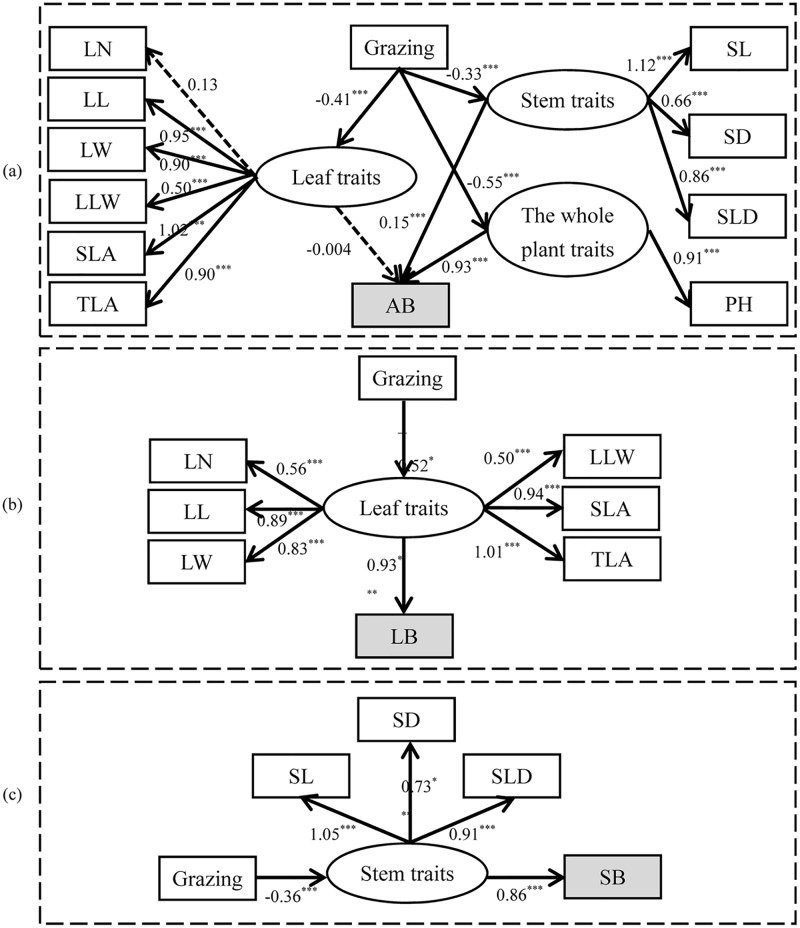
Final results of the SEM analysis of the effects of overgrazing on: (a) AB, (b) LB, and (c) SB of L. chinensis individuals via PFT pathways.Boxes and ellipses denote the observed and latent variables included in the models, respectively. Solid arrows denote the directions and effects that are significant (P<0.001, marked *** in the figure); dashed arrows represent the directions and effects that are not significant (P>0.05). Values associated with arrows represent standardized path coefficients. Estimates of the regression weights in the SEM analysis are given in S2 Table, S3 Table, and S4 Table.